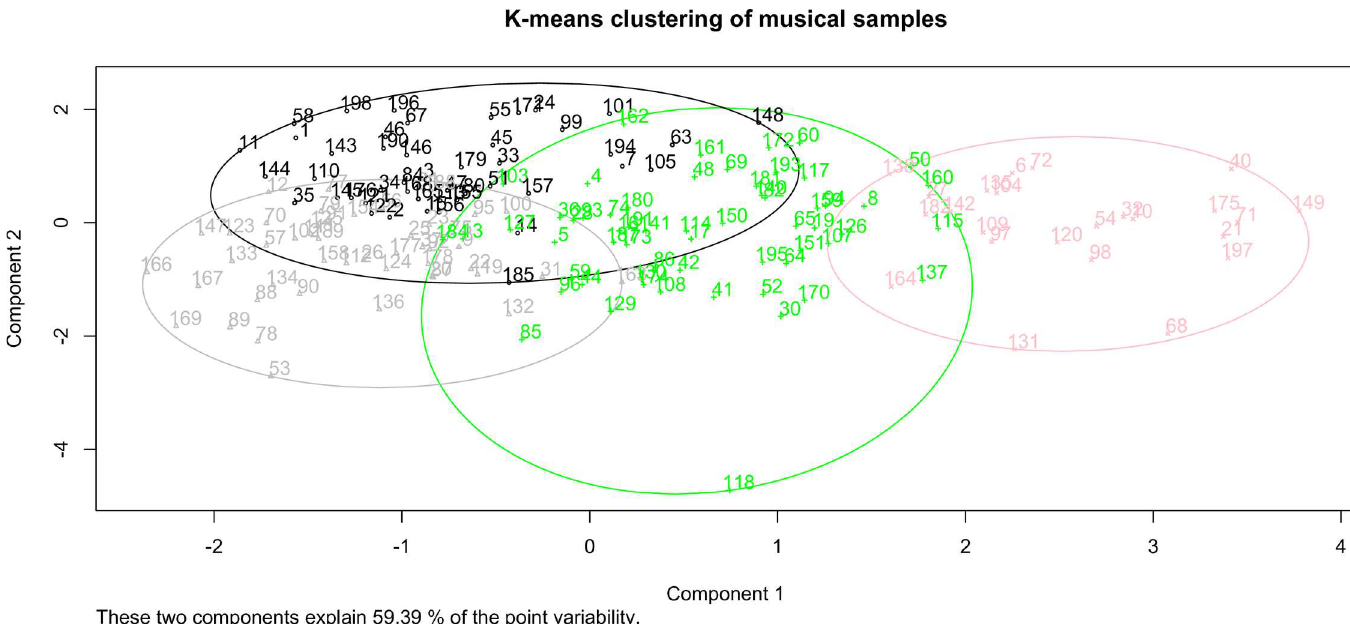
Fig 1. Results of K-means clustering of the stimuli for musical samples. (A) Results are derived from the five factor scores gainedfrom the low-level audio descriptors (see Table 1). Stimuli are labeledwith their Track IDs and plotted in a 2-dimensional representation (Component/Factor 1 and 2) of the four clusters (1 = black, 2 = grey, 3 = green, 4 = pink) presented in Table 2.